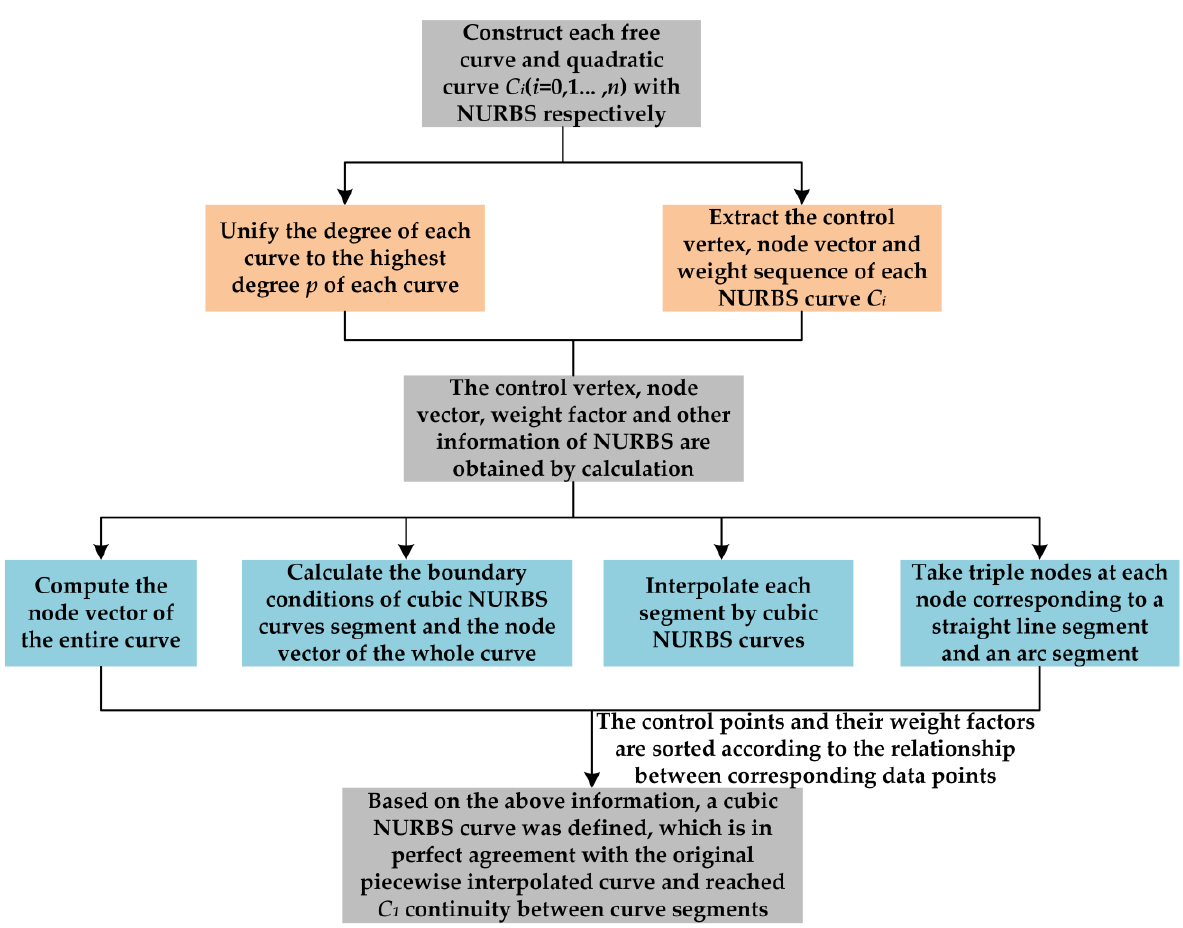
Figure 1. Basic flow of NURBS to express combinatorial curves.